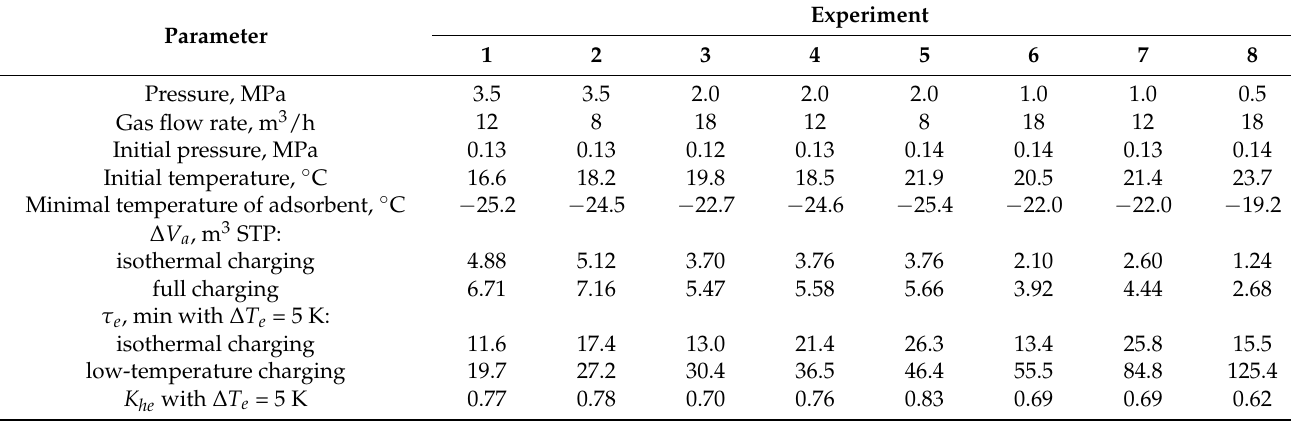
Table 1. Modes and results of the experiments with constant pressure and volumetric gas flow rate. Parameter